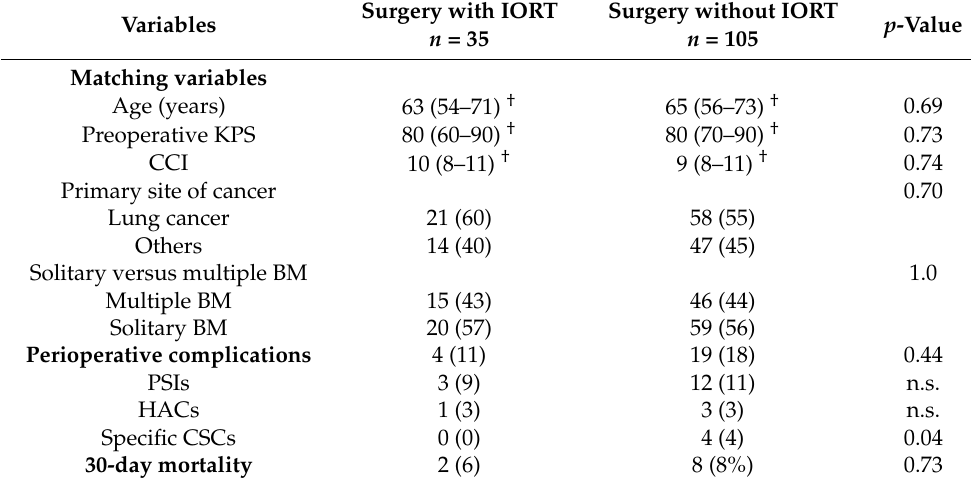
Table 3. Comparative matched-pair analysis on perioperative complication profiles for patients with versus without